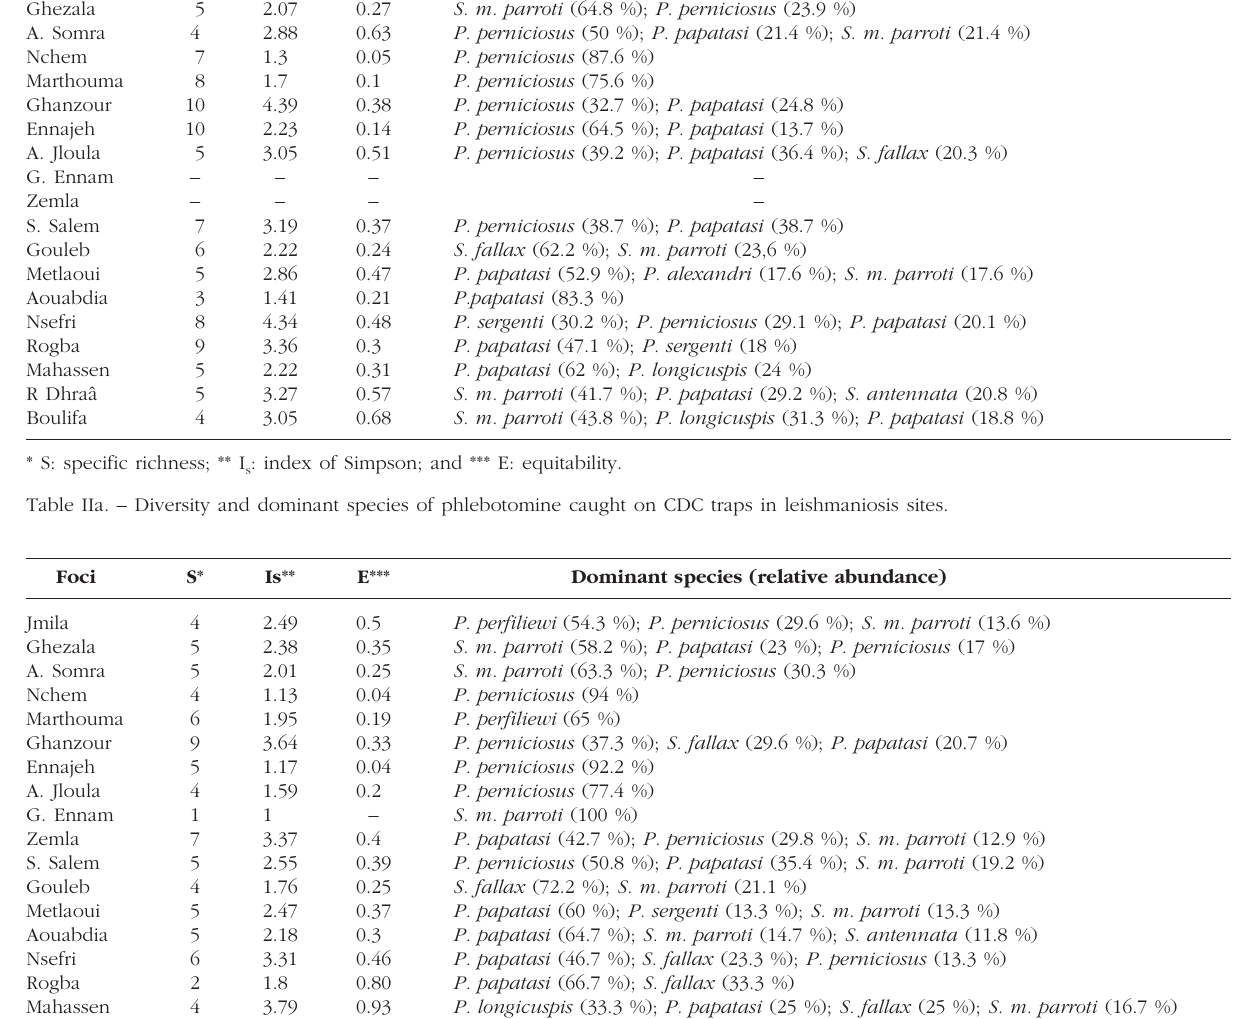
Table IIb. – Diversity and dominant species of phlebotomine caught on sticky traps in leishmaniosis sites.